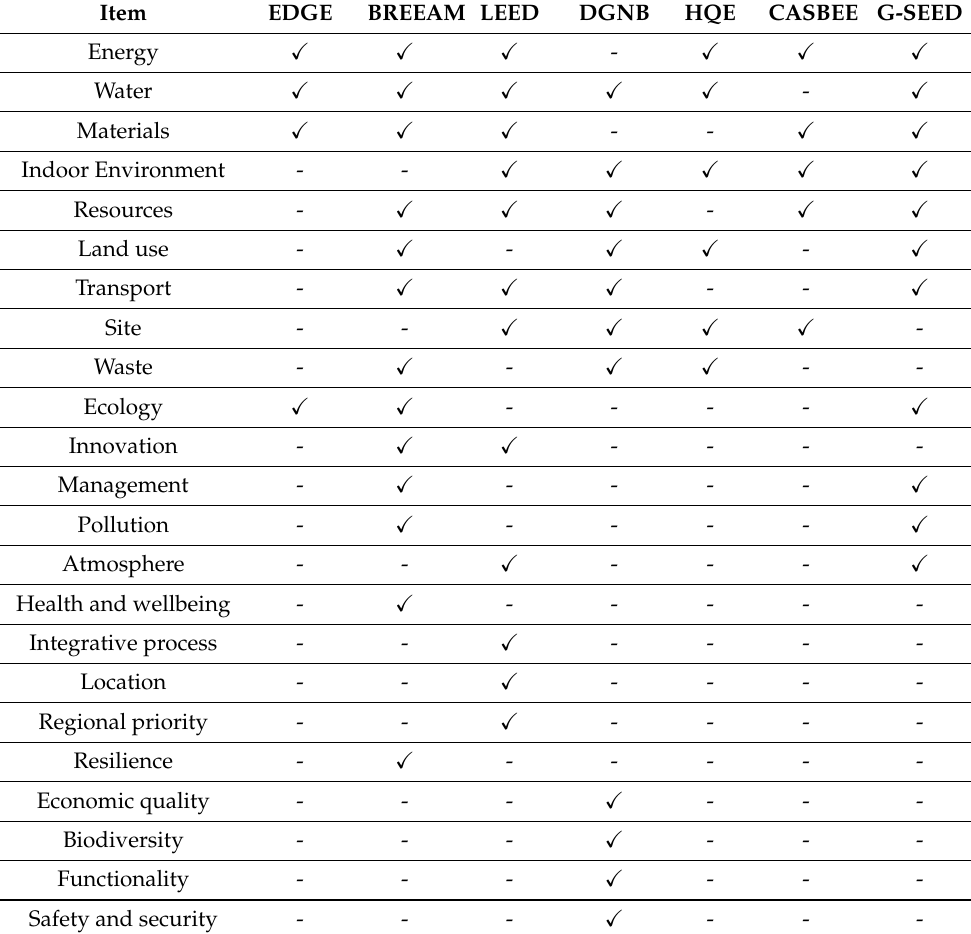
Table 1. Overview of certification criteria of different certification systems [16–22].